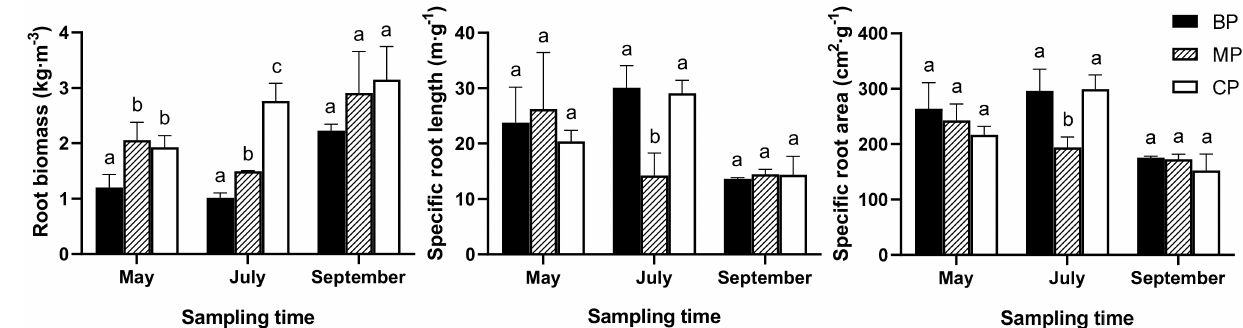
Figure 1. Root biomass, specific root length, and surface area of different sampling time under three forest types. Different lowercase letters indicate significant difference among forest types at 0.05 level, as below. Table 2. Analysis of variance (ANOVA) results of the effects of forest type and sampling time on